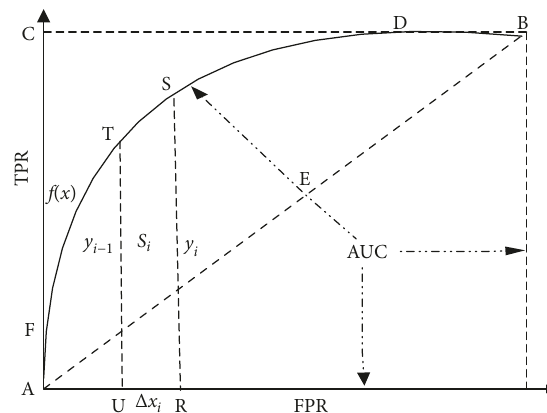
Figure 5: Schematic of ROC curve system [36].